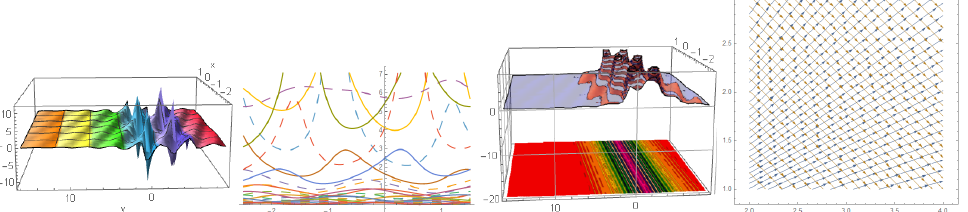
Figure 8. The dynamical behavior of M -shaped funciton with two kinks via c = 1.7, ρ = 4, z 1 = 3, u 8 = 2, η = 2, u 3 = − 1, z 2 = 1, δ = 2, λ = 2, t = 1, and u 6 =